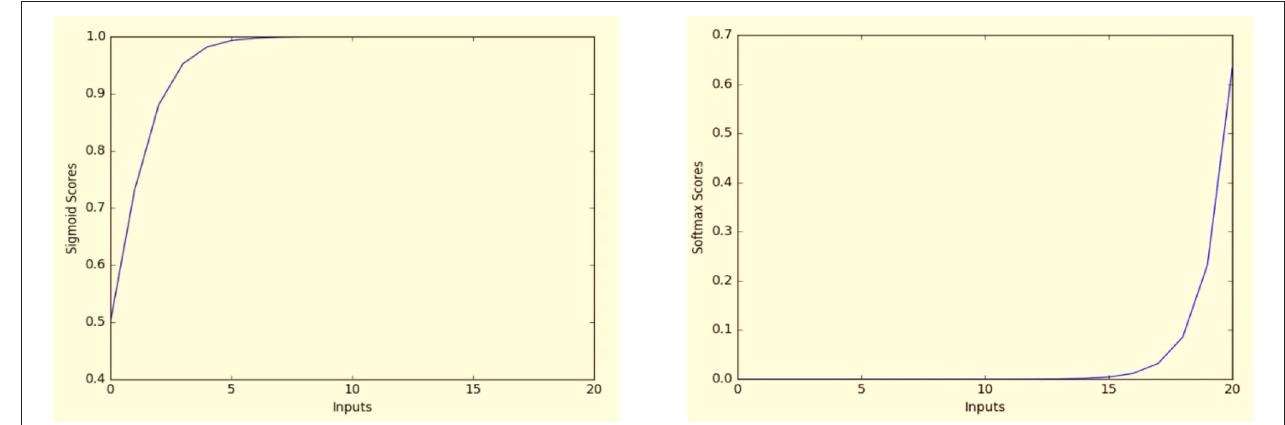
FIGURE 8 | The fundamental property of sigmoid and softmax functions.